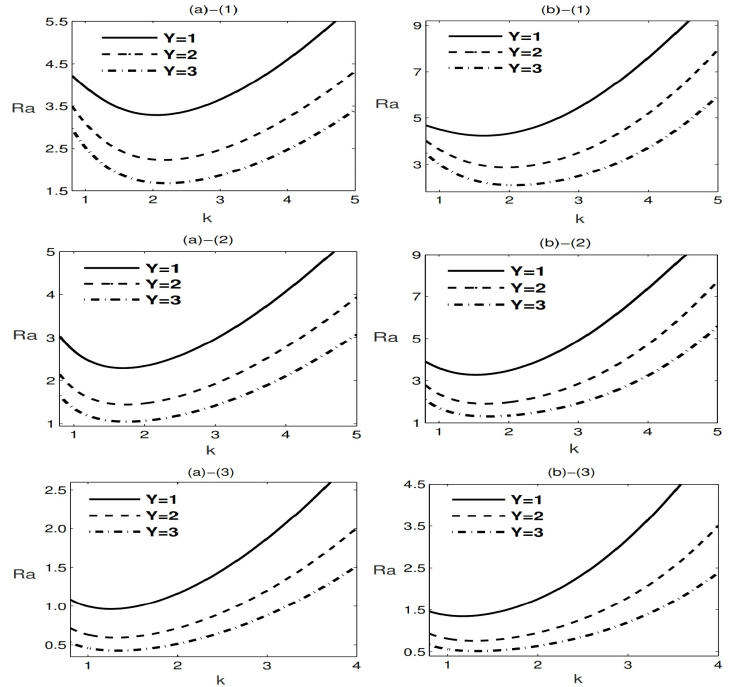
Figure 3: Neutral stability curves for distinct values of Y for (a) 1 J = + and (b) 1 J = − ; for (1) I_C-I_C, (2) I_C-I_CHF, and (3) I_C-F_CHF boundaries.